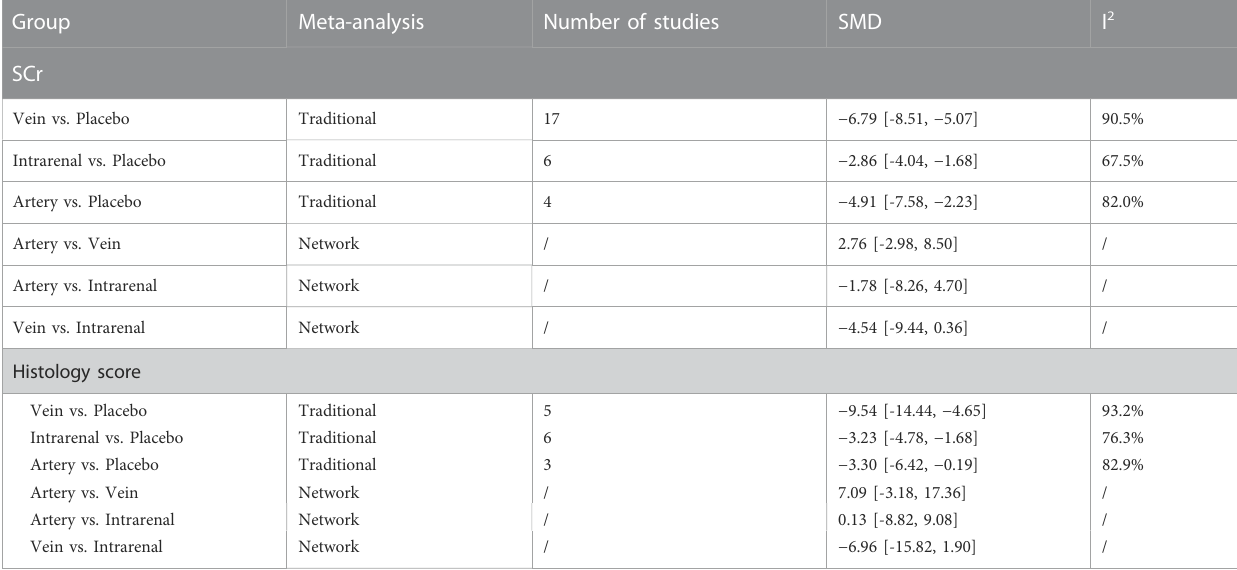
TABLE 1 Comparison of different transplantation routes in high dose